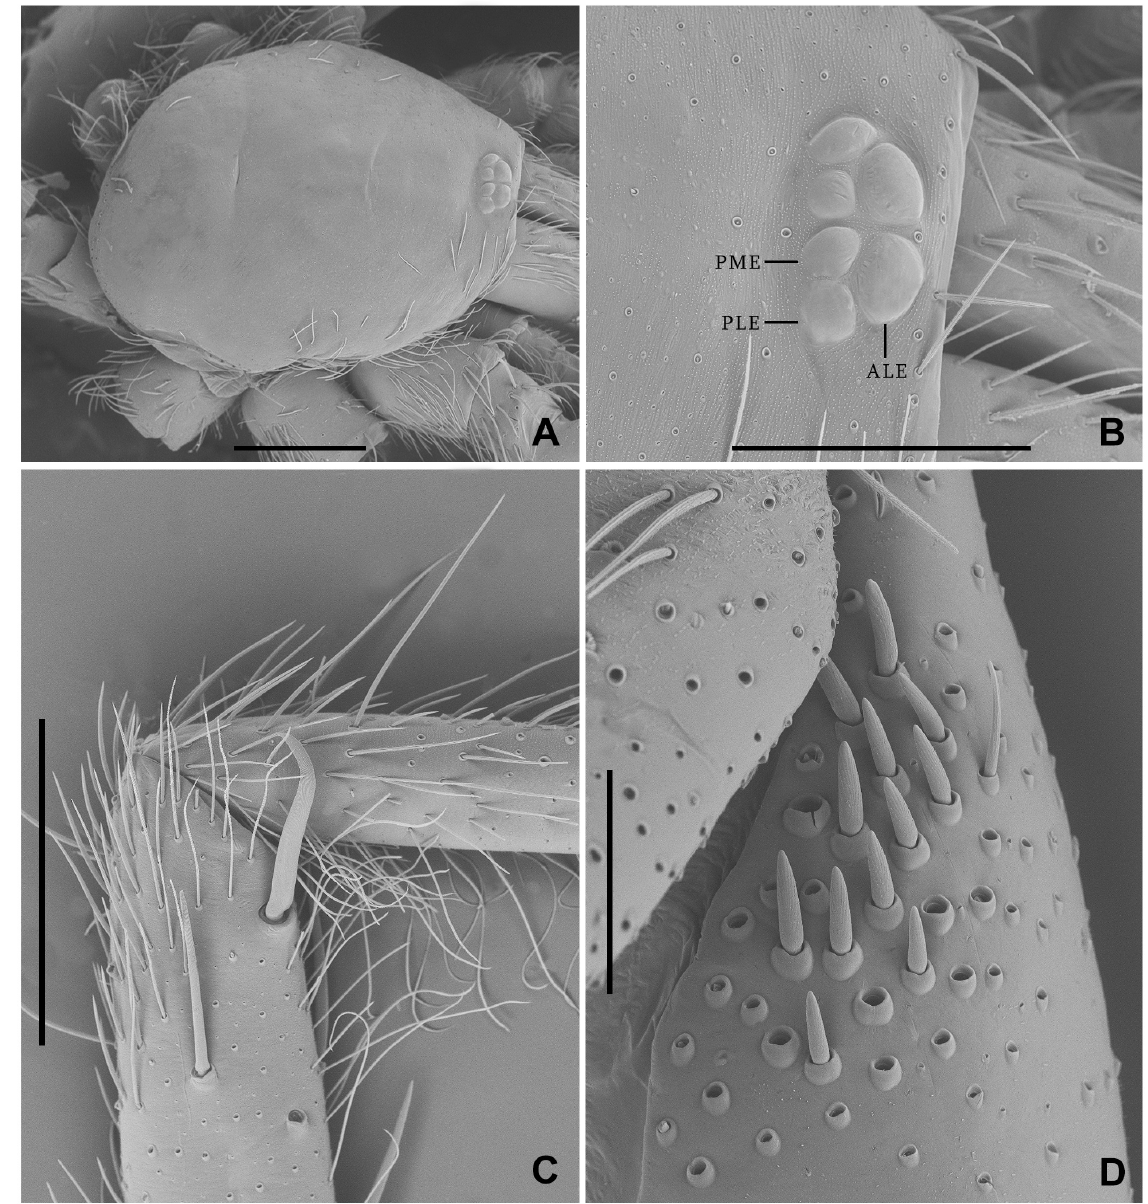
Fig. 9. SEM micrographs of Ammonius benoiti sp. nov. (RMCA 202354). A . Carapace, dorsal view. B . Eye tubercle, dorsal view. C . Tibia I, prolateral view. D . Detail of tibial thorns, retrolateral view. Abbreviations: ALE = anterior lateral eyes; PLE = posterior lateral eyes; PME = posterior median eyes. Scale bars: A = 0.5 mm; B–C = 0.3 mm; D = 0.1